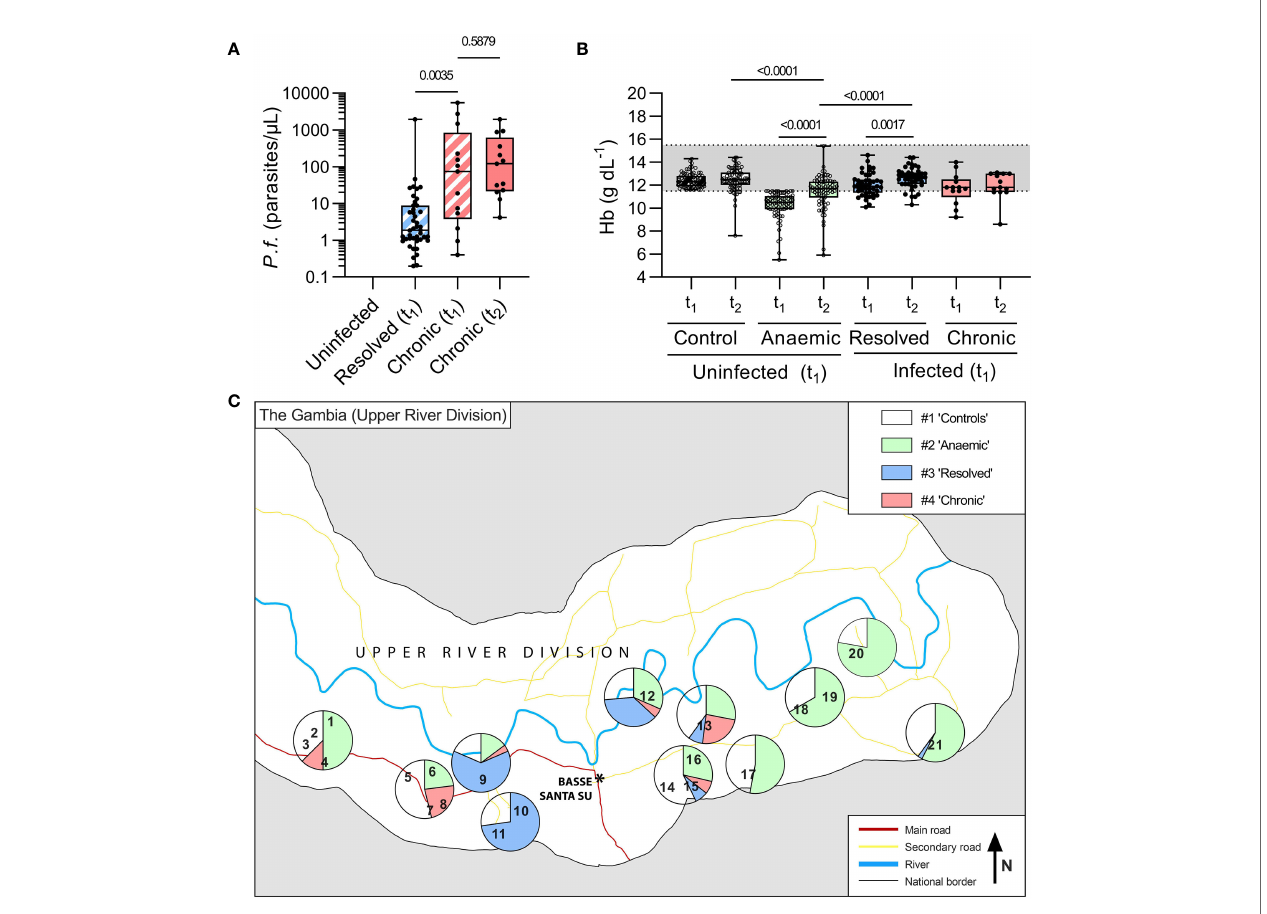
FIGURE 2 | Parasitaemia and anaemia in uninfected children and children with resolved or persistent P. falciparum infections in the Upper River Division of The Gambia. In total, 209 age, sex, and village-matched children were followed over the dry season from initial recruitment in the baseline survey (t 1 ) to follow up (t 2 ) and grouped based on presence of P. falciparum DNA by varATS qPCR at both time-points. ‘ Chronic ’ children were qPCR positive at both t 1 and t 2 ( n =13, 6%), ‘ resolved ’ ( n =44, 21%) were PCR positive at t 1 and negative at t 2 , and the remaining ( n =156, 73%) children were ‘ Uninfected ’ . The uninfected children were de fi ned as anaemic or not based on Hb concentration at t 1 (Hb ≤ 11.5g/dL, n =77). Of those who were qPCR positive at t 1 ( n =57), 77% resolved their infection by t 2 . (A) Parasite burden, determined by varATS qPCR, in parasites/ m L. Mann Whitney test used for comparison between Resolved (t 1 ) and Chronic (t 1 ), hatched boxes. Wilcoxon matched- pairs signed rank test used for comparison between Chronic (t 1 ) and Chronic (t 2 ), with p -values shown. (B) Haemoglobin (Hb g/dL) by hemocue at baseline (t 1 ) and recall (t 2 ). (C) The study participants came from 21 villages (numbered, see Table S6 ). The proportions of children in each group in each village are represented by pie charts. Where only very small numbers of children from a village were tested, villages have been clustered for analysis, with a breakdown per village/cluster reported in Table S6